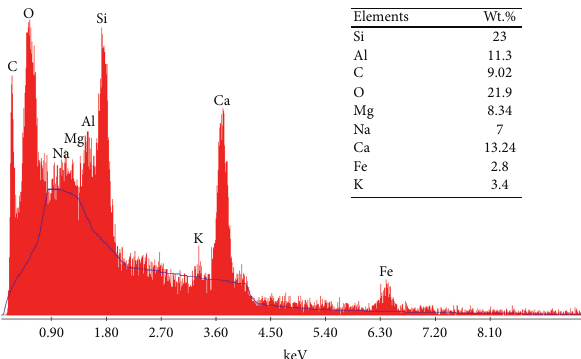
Figure 4: EDX microanalysis spectrum of Oued Sebou sediment.